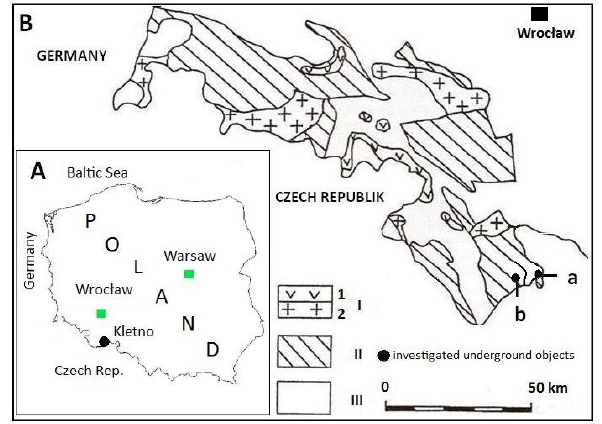
Fig. 1. Fig. 1. Location of Bear Cave (a) and Fluorite Adit (b) in Kletno on a map of Poland (A) and a geological sketch of the Polish part of the Sudetes (B). I: igneous rocks: 1: intrusive rocks, 2: extrusive rocks, II: metamorphic rocks, III: sedimentary rocks. Fig. 2.